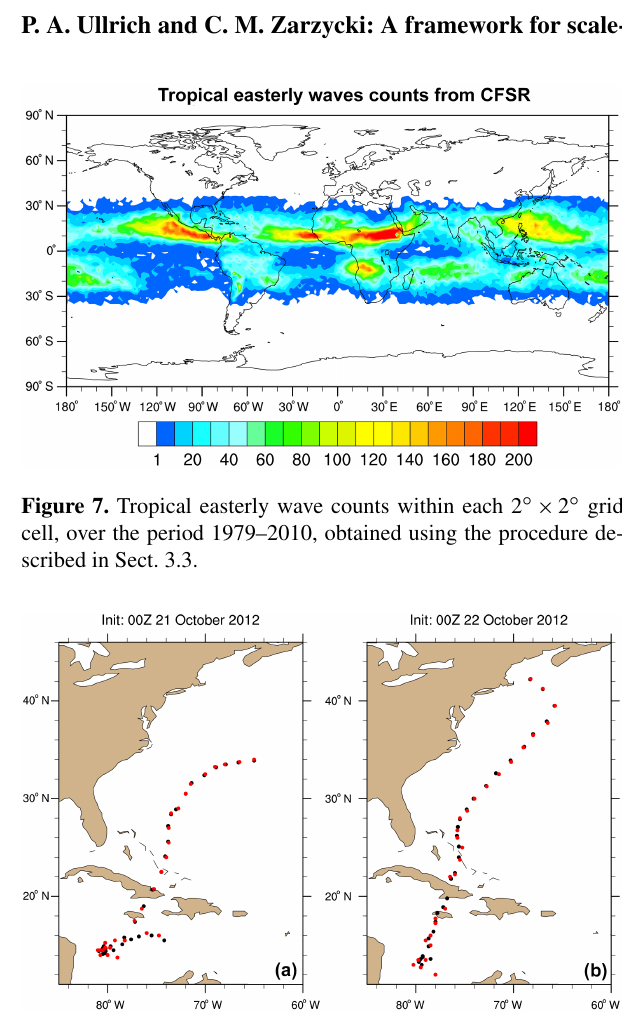
Figure 8. Forecast CAM trajectories for Hurricane Sandy initial- ized at 00Z on (a) 21 and (b) 22 October 2012. Black dots indicate trajectories defined using the NCEP operational vortex tracker with red dots denoting trajectories defined using a sample configuration of TempestExtremes.